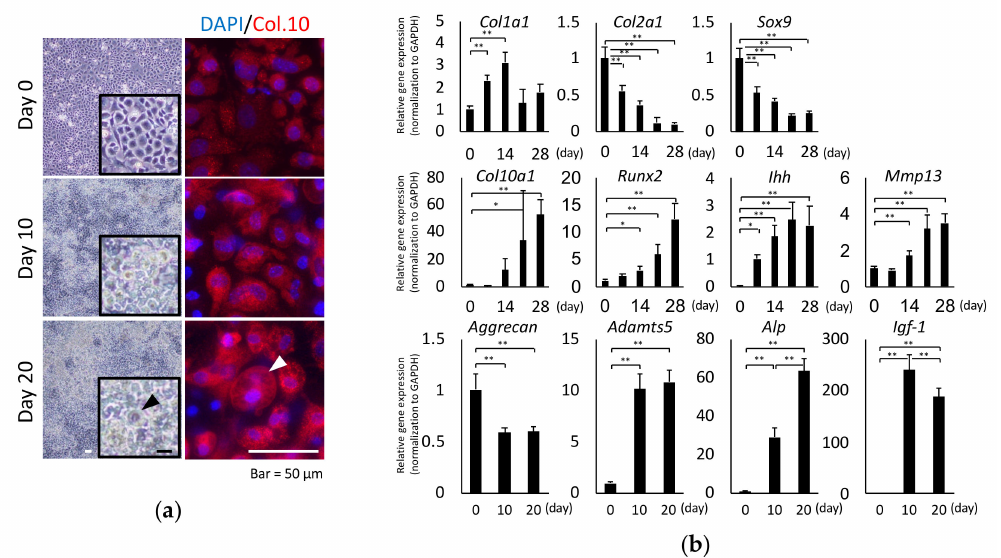
Figure 1. Morphological and gene expression changes during hypertrophic di ff erentiation. ( a ) Microscopic observation of hypertrophic-like changes in chondrocytes (allows). Note that the volume of the cell is drastically increased. Chondrocytes were co-stained with 4 (cid:48) 6-diamidino-2-phenylindole (DAPI) and type X collagen immunoglobulin G (IgG). Scale bar = 50 µ m. ( b ) Time course changes in the expression of marker genes during the hypertrophic di ff erentiation of chondrocytes. The increased expression of hypertrophic markers was significant after 14 days ( Runx2 : p < 0.01; Mmp13 : p < 0.0001; Ihh : p < 0.001) and 21 days ( Col10a1 : p < 0.0001) compared with expression before induction (0 day). Gene expression levels were measured by quantitative real-time polymerase chain reaction (PCR) ( n = 3 per group; * p < 0.05; ** p <